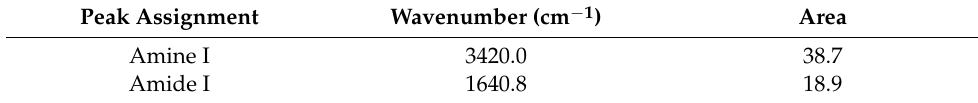
Figure 4. Deconvoluted spectra of CBX-MG-PEI. The peaks at 1640.8 cm − 1 and 3420 cm − 1 were taken as a reference to peak area ratios of amide I/amine I. Table 3. Determination of the areas of the peaks in the FTIR spectra of CBX-MG-PEI.